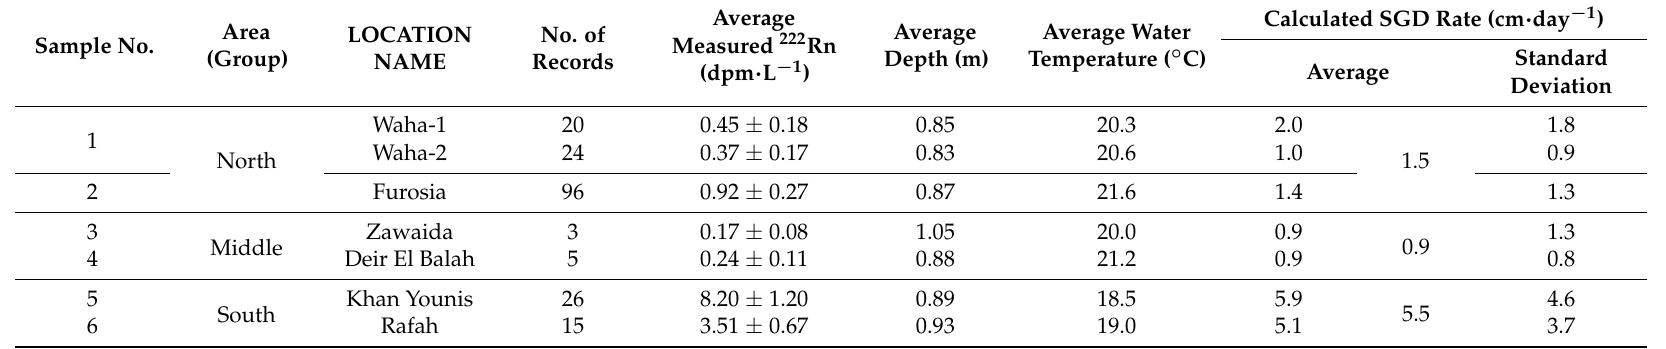
Table 3. Results summary of continuous 222 Rn